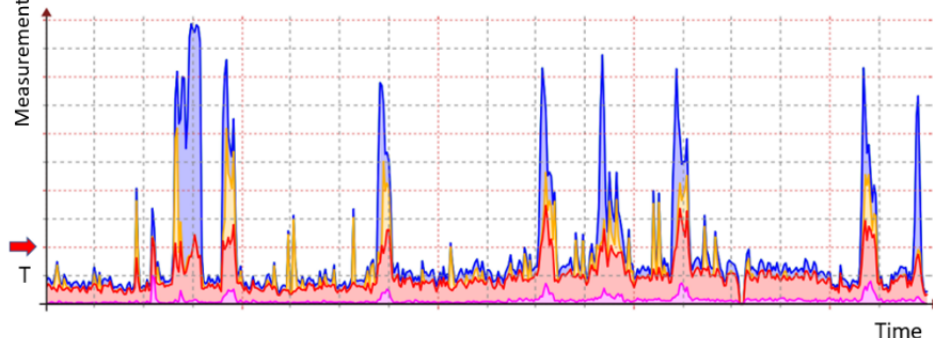
Figure 10. The real-time monitoring process of the actual operation of plastic injection machines.